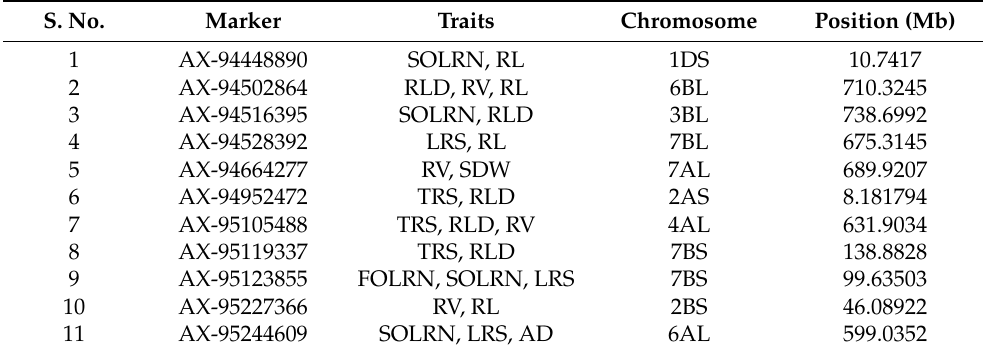
Table 4. Pleiotropic quantitative trait nucleotides